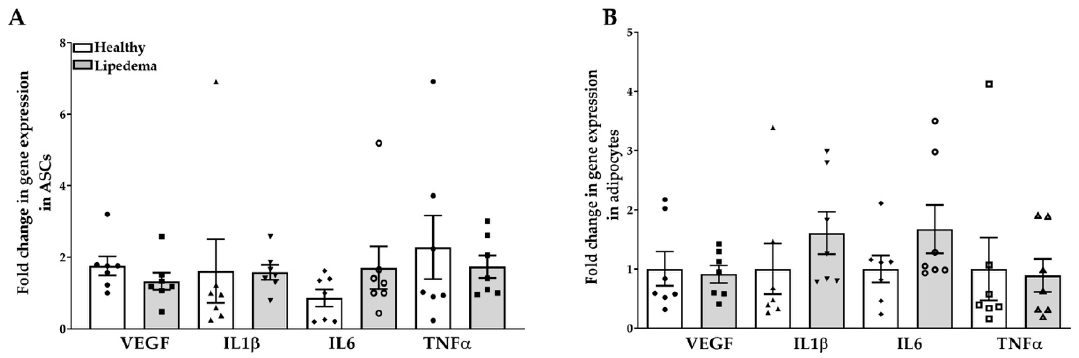
Figure 3. Expression of inflammation-associated genes in 3D spheroids derived from lipedema and healthy ASCs. The qRT-PCR data showed a similar gene expression of VEGF, IL-1 β , IL-6 and TNF α in ( A ) undifferentiated and ( B ) differentiated 3D spheroids ( n = 7 per group). The gene expression of the differentiated adipocyte spheroids is calculated from the percent of undifferentiated spheroids of each group. The results are displayed as scatter plots with bars. The values are the mean ± SEM.